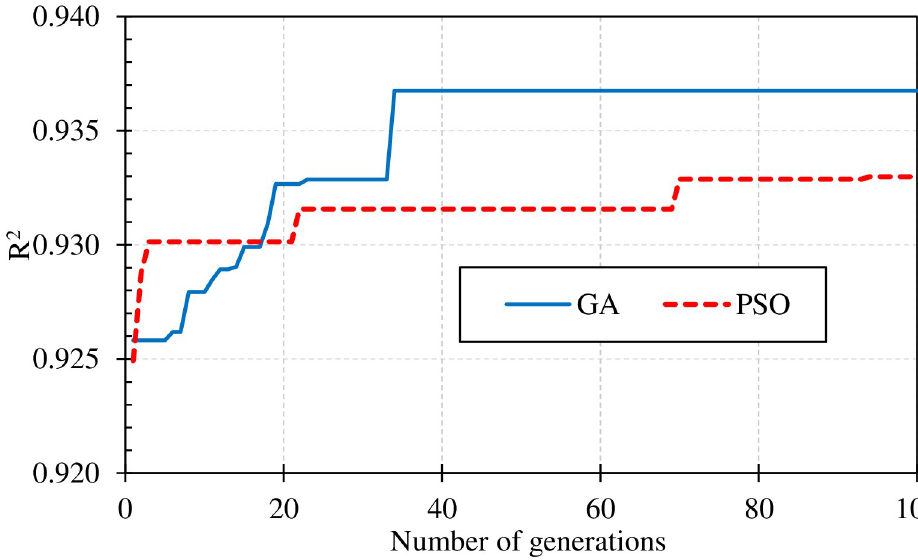
Fig 9. Hyper-parameters tuning using RF-GA and